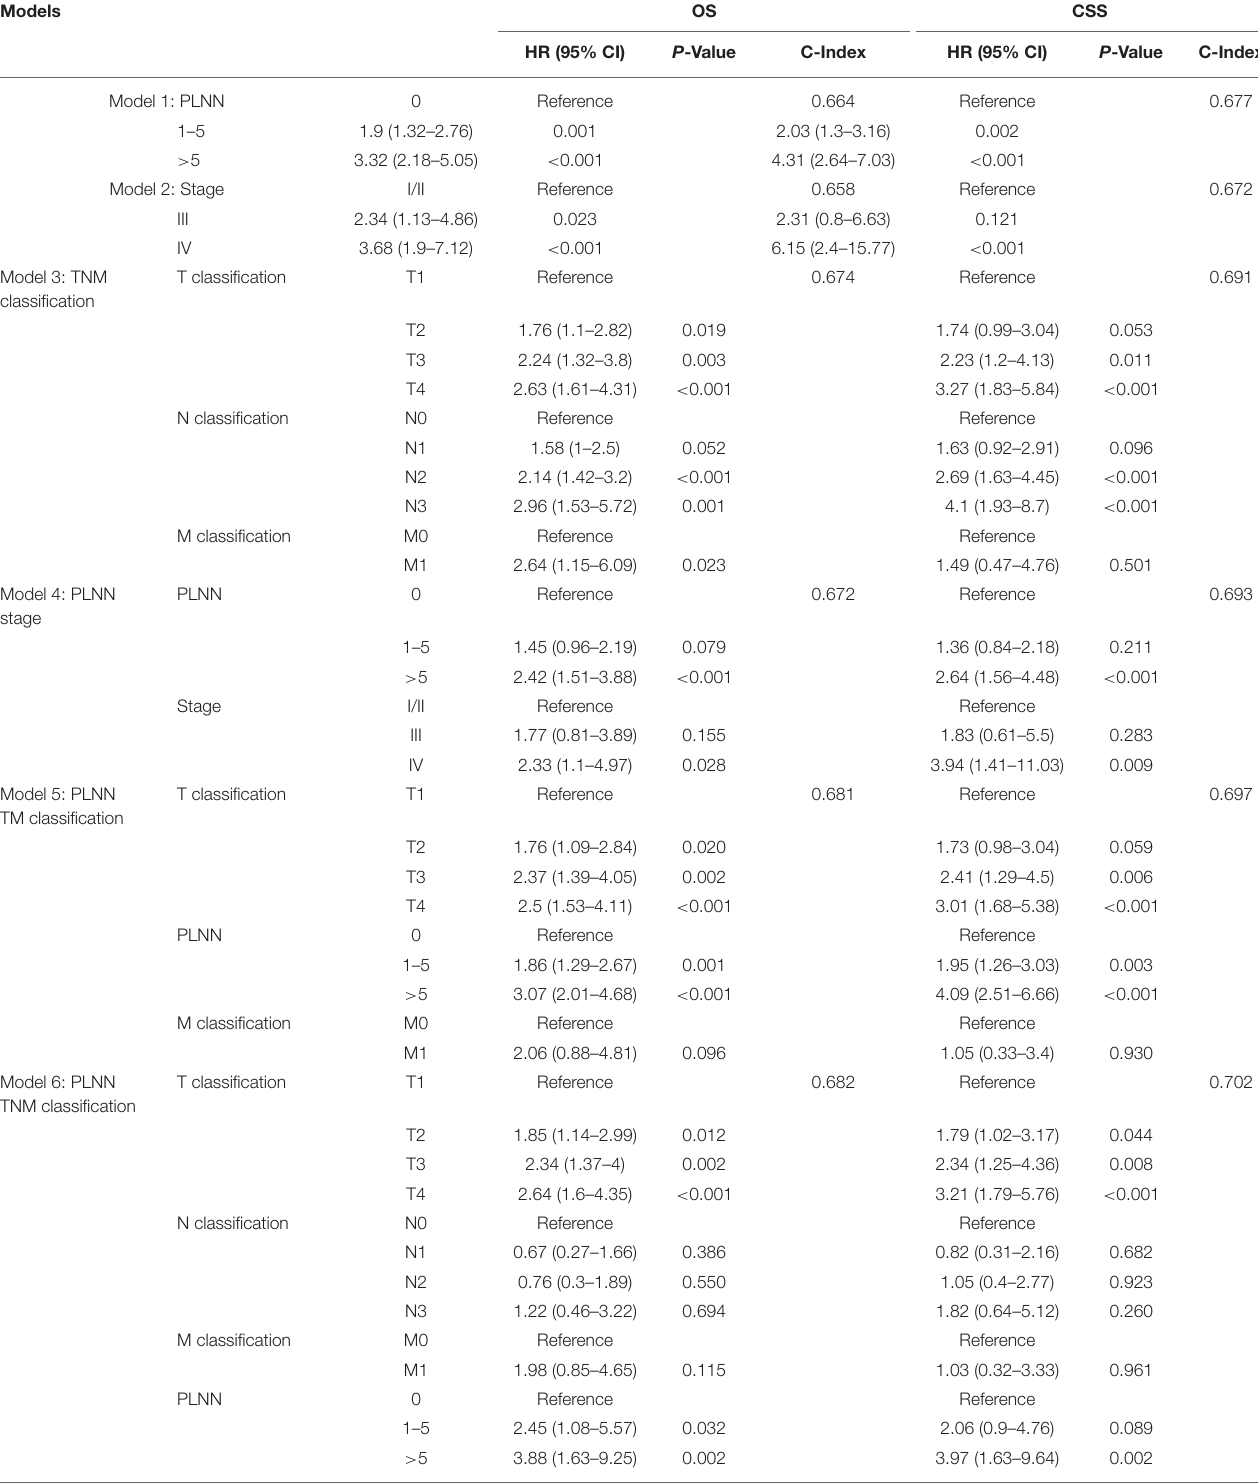
TABLE 3 | Comparison of six survival predicting models based on different permutations and combinations of PLNN (with the cut-off value of 1 and 5), AJCC T- (T1–T4), N- (N0–N3), M- (M0–M1) classification and AJCC cancer stage systems (Stage I–IV).